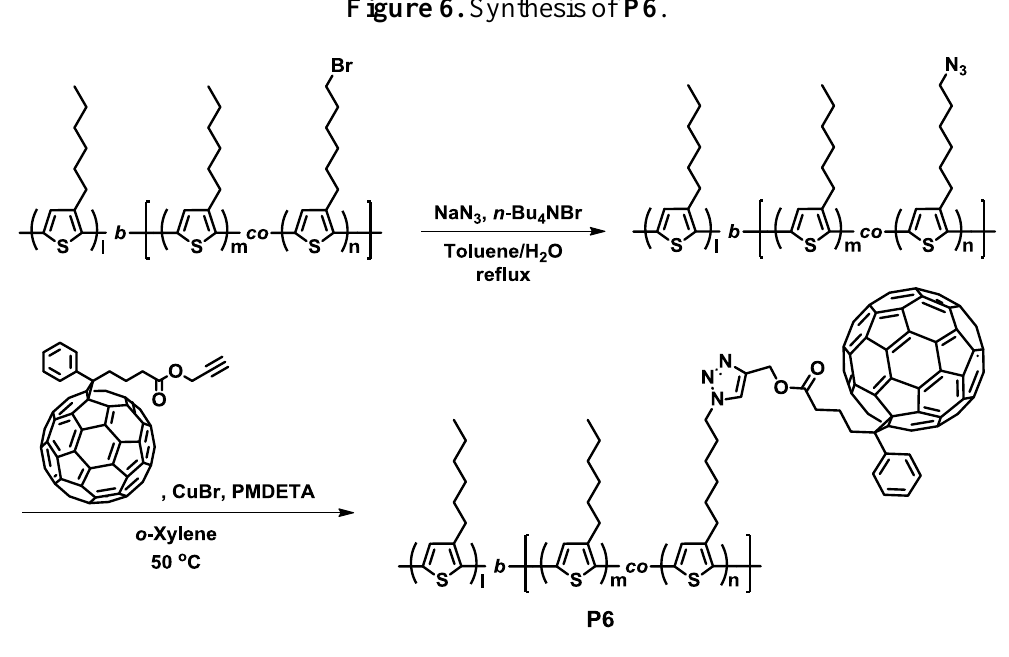
Figure 6. Synthesis of P6